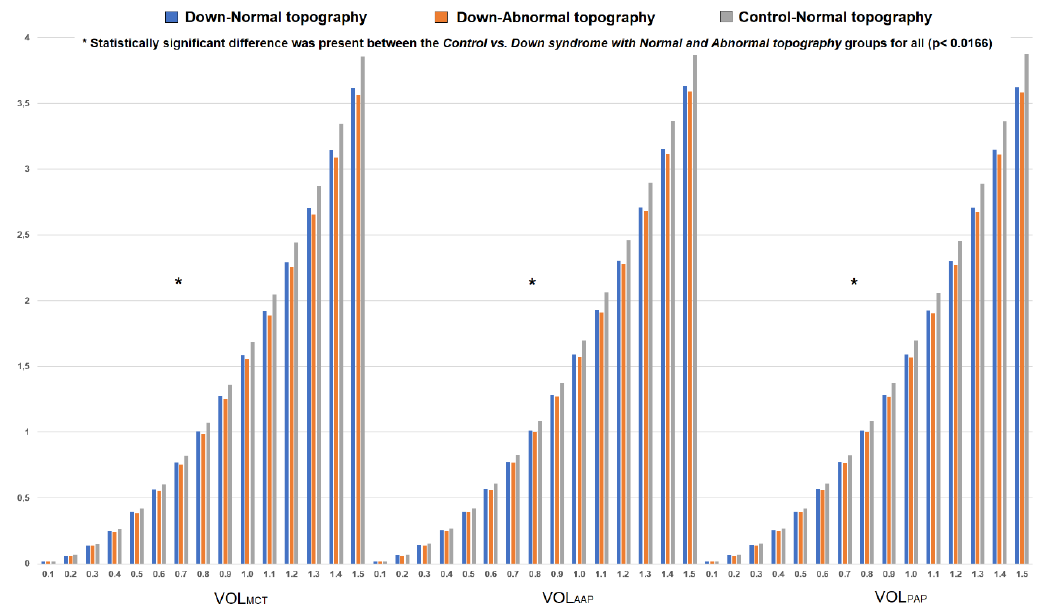
Figure 3. Change in corneal volume for each 0.05 mm step of the radius value (up to 1.5 mm in diameter) centred to the thinnest point (VOL MCT ) and corneal apex (VOL AAP and VOL PAP ) in the control, Down syndrome (DS) with normal topography and DS with abnormal topography groups.